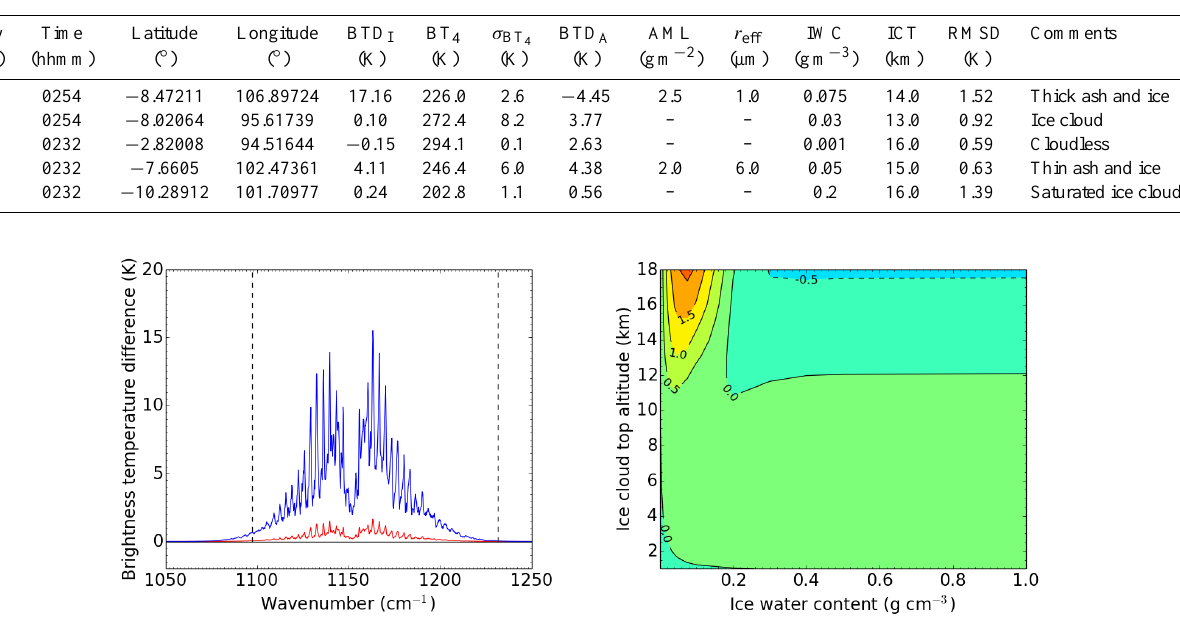
Figure 3. (Left panel) The difference between a spectrum with background SO 2 and with a SO 2 plume between 17 and 19km giving a total column of 10 (100)DU, red (blue) line. The dashed vertical lines locates the 1097.25 and 1231.5cm − 1 channels. (Right panel) The 1231.5–1097.25cm − 1 brightness temperature difference BTD I (K) for a horizontal water ice cloud of 1km thickness as a function of ice cloud top height and ice water